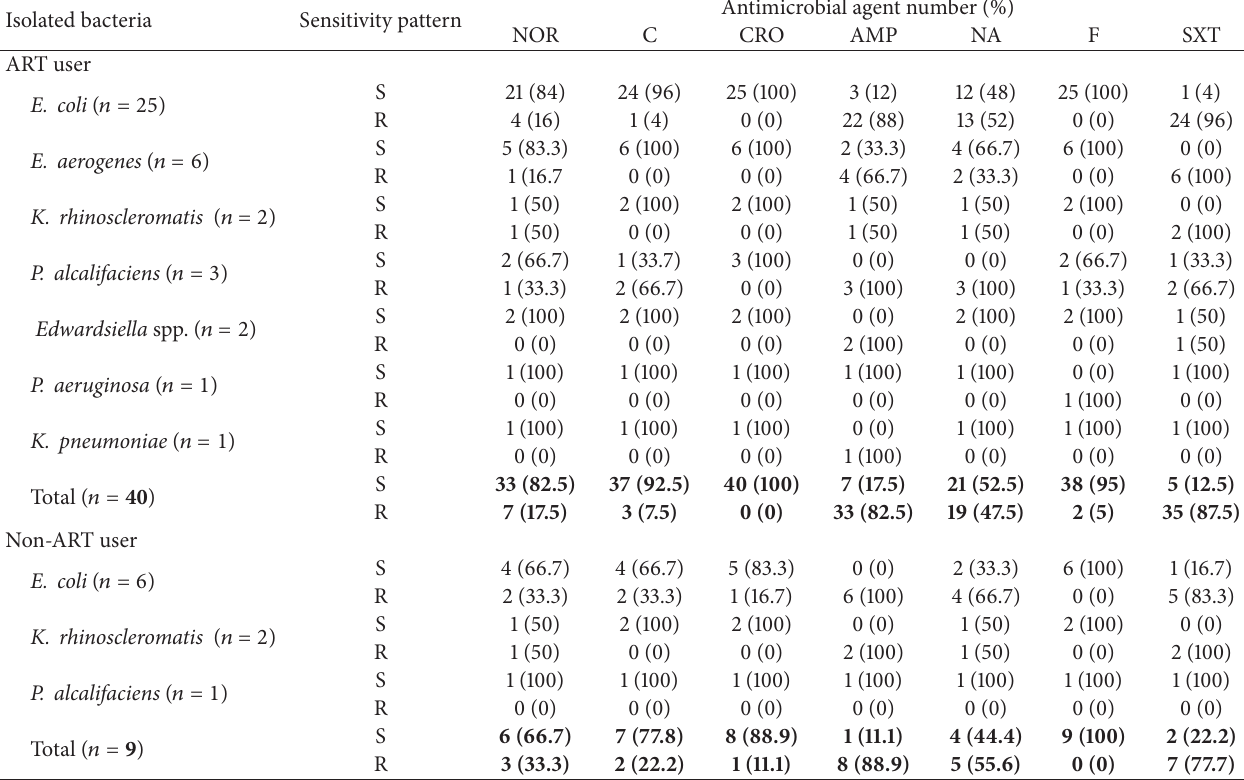
Table 5: Antimicrobial sensitivity pattern of Gram negative bacteria isolated from urine culture of ART and non-ART user patients, Jimma University Specialized Hospital, Ethiopia,